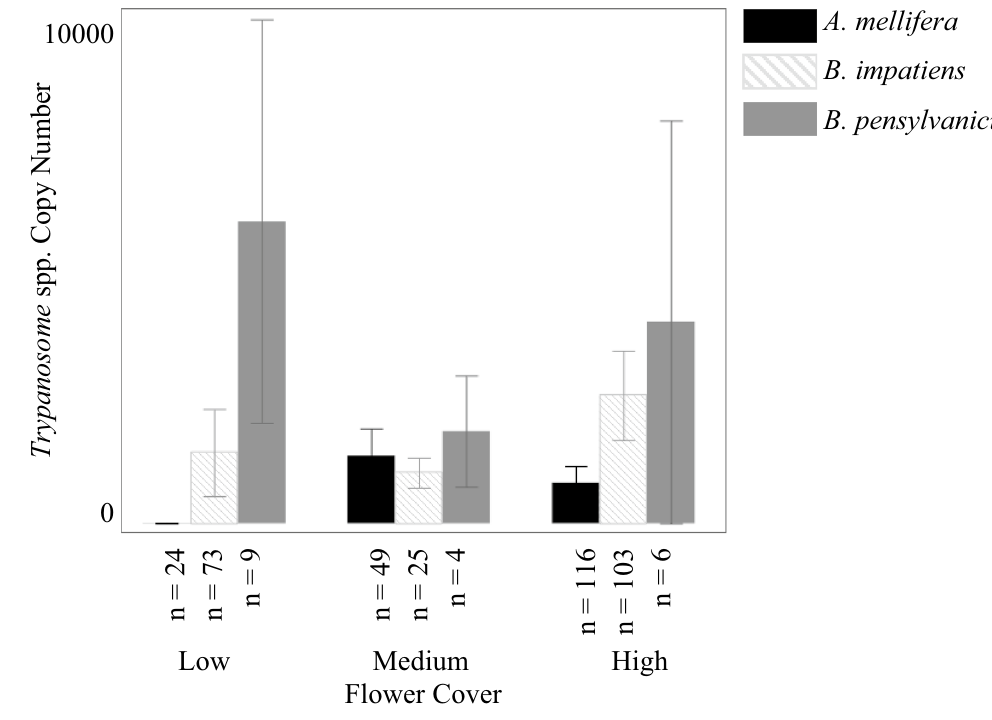
Figure 2. Copy number per 1 µl of template (approximately 3.3 ng of RNA) of Trypanosome spp. for A. mellifera, B. impatiens, and B. pensylvanicus across the different levels of flower